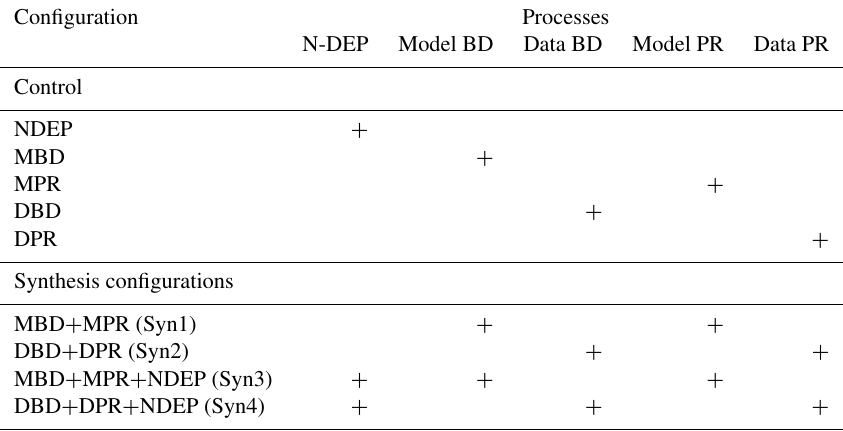
Table 1. Summary of model configurations including different processes. Process abbreviations are “N-DEP”, “Model BD”, “Data BD”, “Model PR” and “Data PR”. N-DEP represents the atmospheric nitrogen input into the surface ocean according to the estimate by Lamarque et al. (2011); Model BD and Data BD represent model- and data-based benthic denitrification, respectively; Model PR and Data PR are model- and data-based benthic phosphorus regeneration,